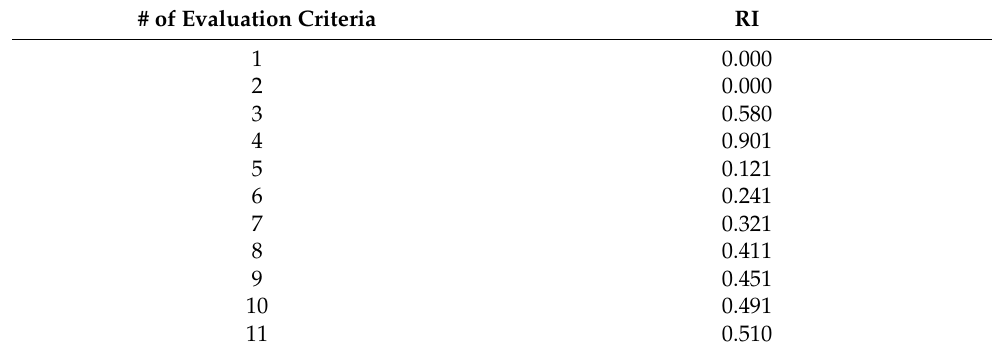
Table 8. The number of evaluation criteria and